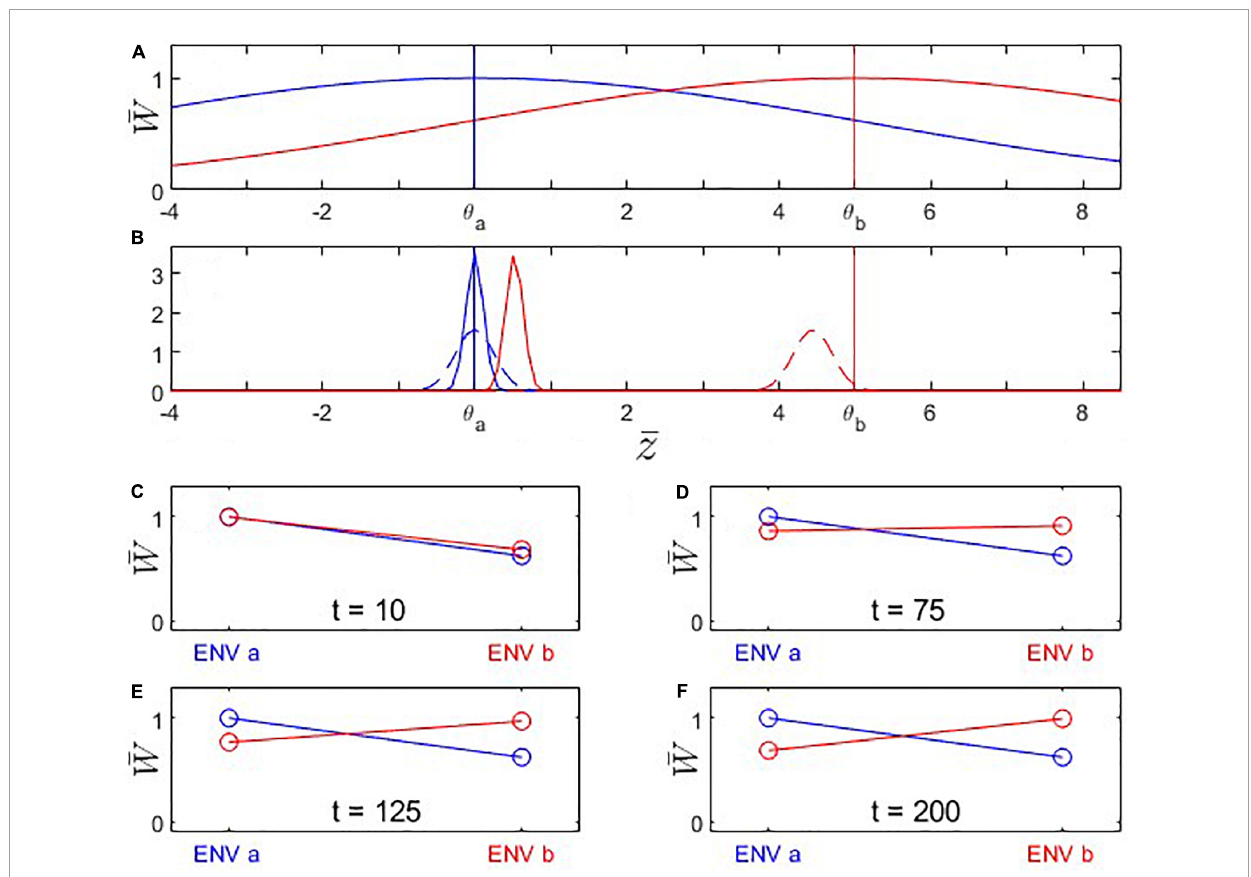
FIGURE1 Fitness landscapes, trait evolution, and reciprocal-transplant experiments under Scenario 1: Trait optima are stationary; initial trait value ¯ z 0 is located at the fitness optimum for environment a . Population B branches off from population A at time t 0 and adapts to the new environmental conditions dictated by the changed fitness landscape. (A) Fitness landscapes for environment a (blue) and b (red); vertical lines indicate the location of the fitness optima. (B) Probability distributions for phenotypic means after t = 10 (solid) and 200 (dashed) generations of evolution. Note that population A ’s (blue) mean trait value remains in place while population B evolves toward the new trait optimum θ b = 5. Also note that the width of the distribution shown is the variance of the mean phenotype across hypothetical replicated populations (arising due to genetic drift), not the genetic variance of a single population (which is assumed to remain constant). (C–F) Fitness plots for hypothetical reciprocal transplant experiments performed at t = 10, 75, 125, 200 (Left side of each panel: fitness of populations A (blue) and B (red) in environment a ; right side: fitness of populations A and B in environment b ). Parameters: ¯ z 0 , a = ¯ z 0 , b = 0; θ a = 0; θ b = 5; W max , a = W max , b = 1; ω a = ω b = 5; σ a = σ b = 1 . 135; h 2 a = h 2 b = 0 . 224; N a = N b =